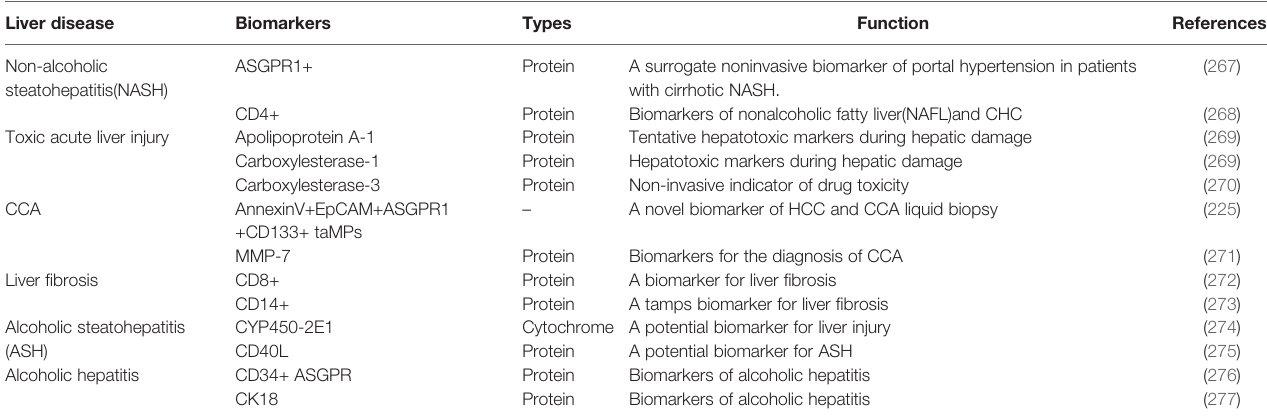
TABLE 4 | EVs-associated proteins as biomarkers of liver